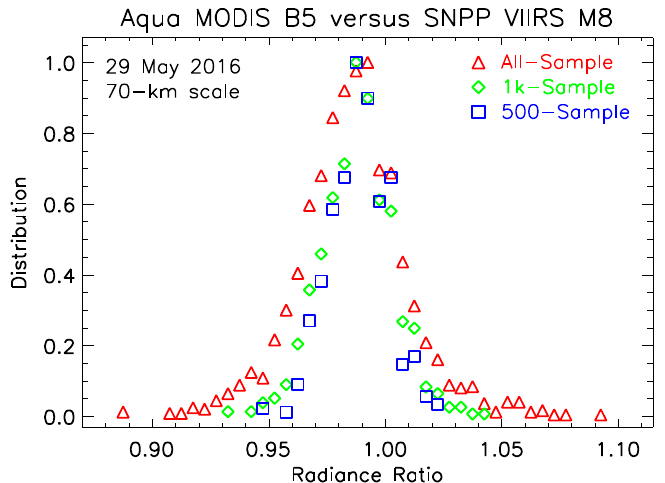
Figure 8. The three ratio distributions of Aqua MODIS B5 versus SNPP VIIRS M8 of the 29 May 2016 event, taken at the 70-km scale, for the sample-unconstrained condition (red stars), the constrained size 1000 samples (green diamonds), and the constrained size at 500 samples (blue squares).